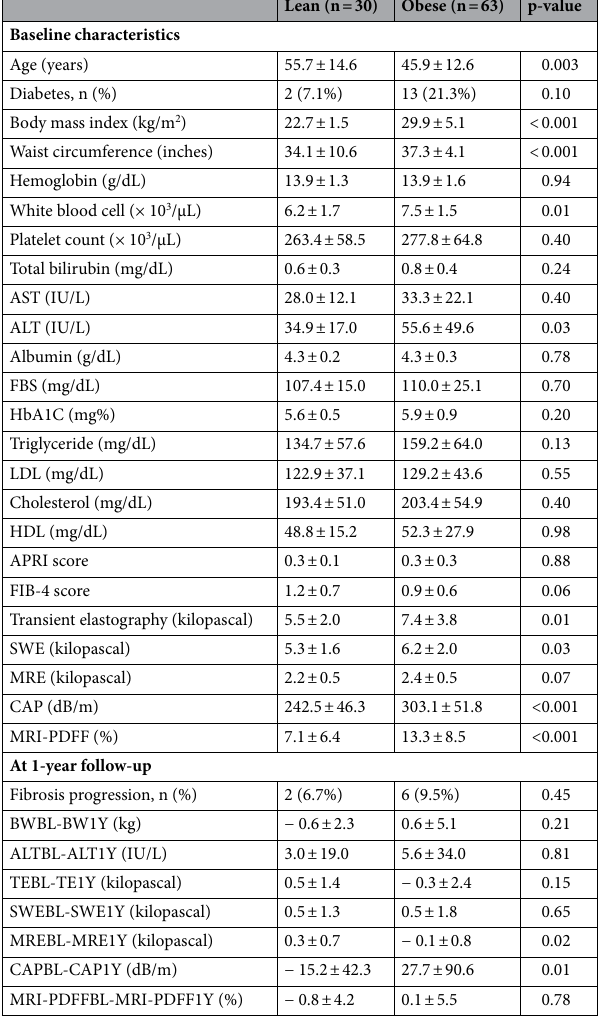
Table 3. Baseline characteristics and change of serum simple fibrotic marker, elastography and steatosis value in Lean and obese NAFLD. AST aspartate aminotransferase, ALT alanine aminotransferase, APRI AST to Platelet Ratio, BW body weight, BL baseline, CAP controlled attenuation parameter, FBS fasting blood sugar, FIB-4 Fibrosis-4, HbA1c Glycated haemoglobin, HDL high density lipoprotein, LDL low density lipoprotein, MRE magnetic resonance elastography, MRI magnetic resonance imaging, PDFF proton density fat fraction, SWE shear wave elastography, TE transient